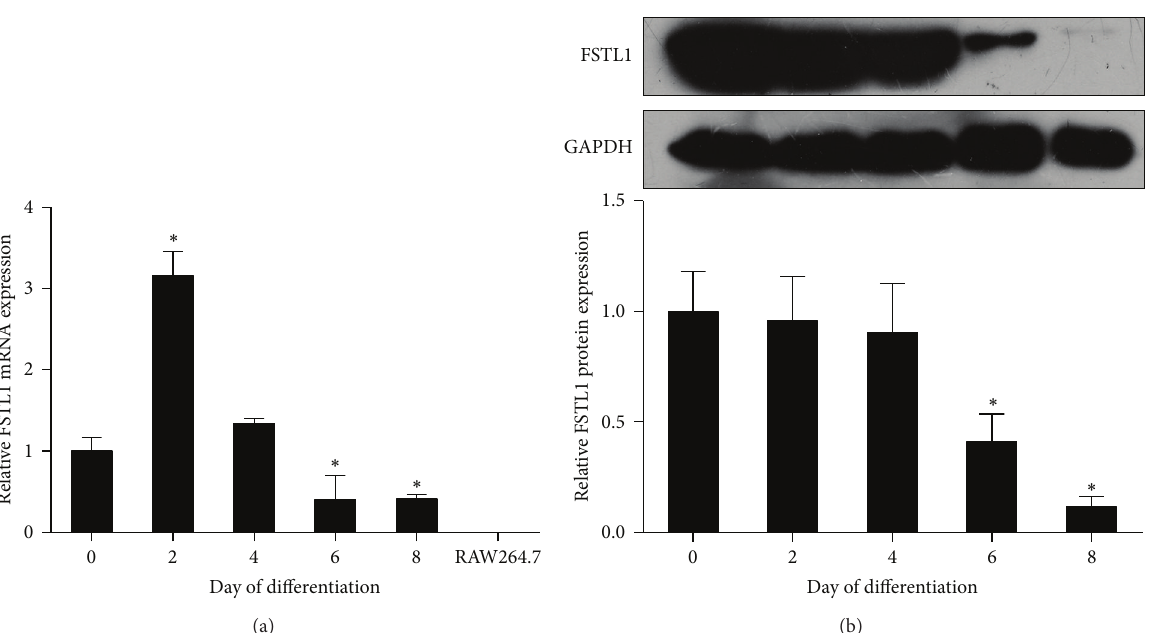
Figure 1: FSTL1 expression is downregulated during differentiation of 3T3-L1 preadipocytes. (a) FSTL1 mRNA expression was evaluated by quantitative RT-PCR in the course of 3T3-L1 preadipocyte differentiation and in RAW264.7 cells. Relative mRNA expression was normalized to 𝛽 -actin and expressed as fold of D0 value. (b) FSTL1 protein expression in differentiating preadipocytes was assessed by Western blot analysis (top) and quantified by densitometry (bottom). Relative protein expression was normalized to GAPDH and expressed as fold of D0 value. Data are mean ± SE; 𝑛 = 3 . ∗ 𝑃 < 0.05 versus undifferentiated preadipocytes (D0).